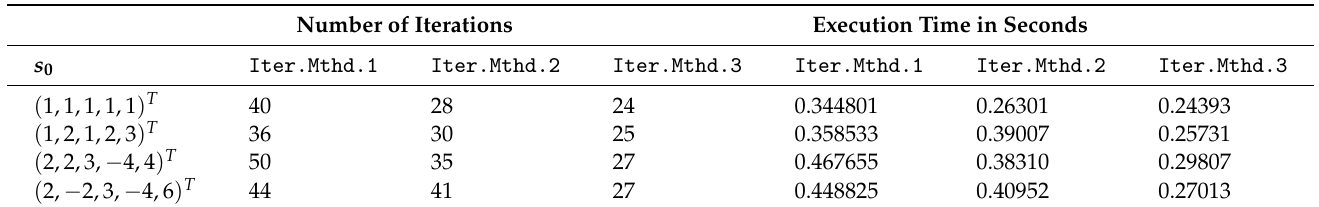
Table 1. The first three techniques have numerical data for Figures 1–8 by using Example 1.